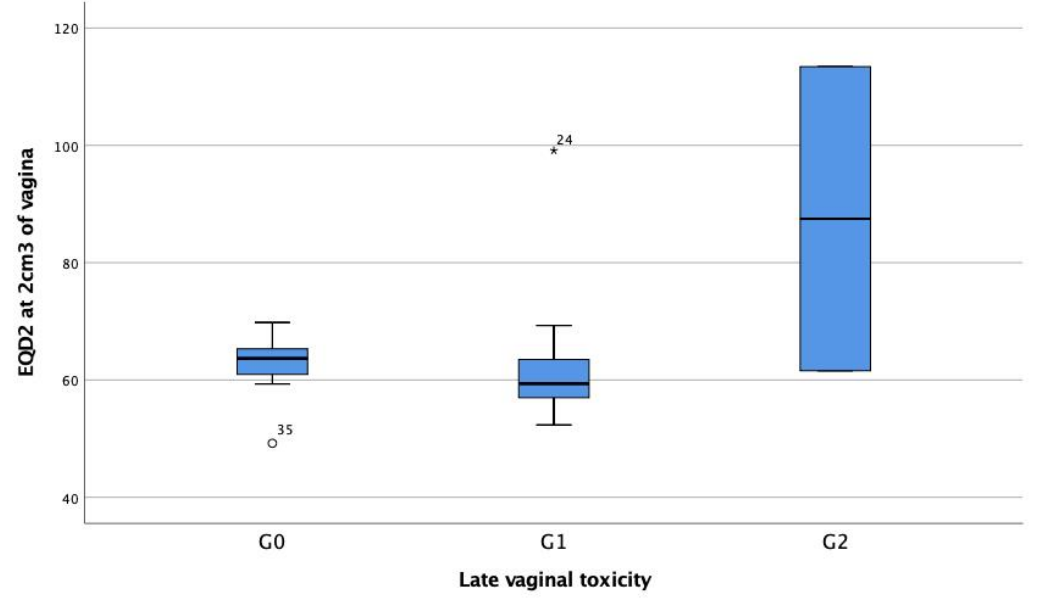
Figure 1. The distribution of EQD2 ( α / β = 3Gy) in Gy at the most exposed 2 cm 3 of vagina in relation to the grades of late vaginal toxicity.